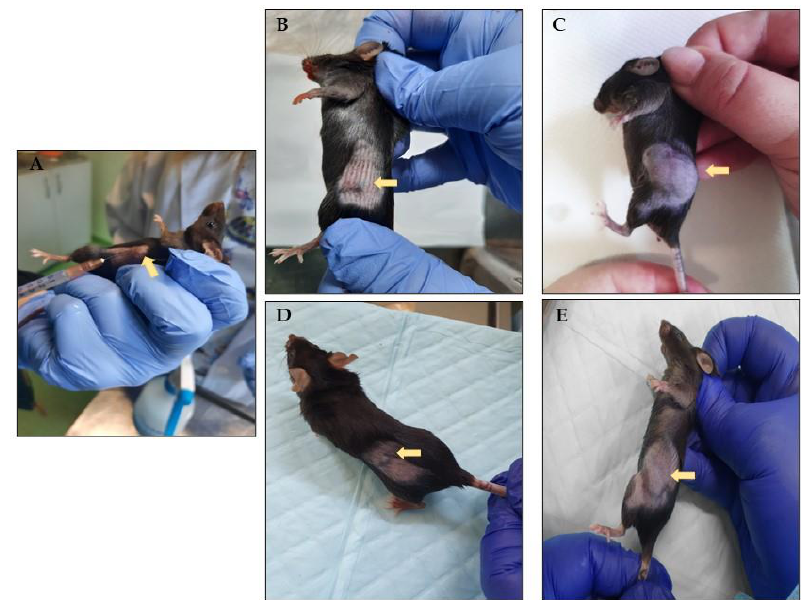
Figure 2. Tumor growth variation following the B16F10 cells inoculation ( A ). First measurable tumors in melanoma group ( B ) and melanoma + rhodoxanthin group ( D ). Last measurement of the tumors in melanoma group ( C ) and melanoma + rhodoxanthin group ( E ).